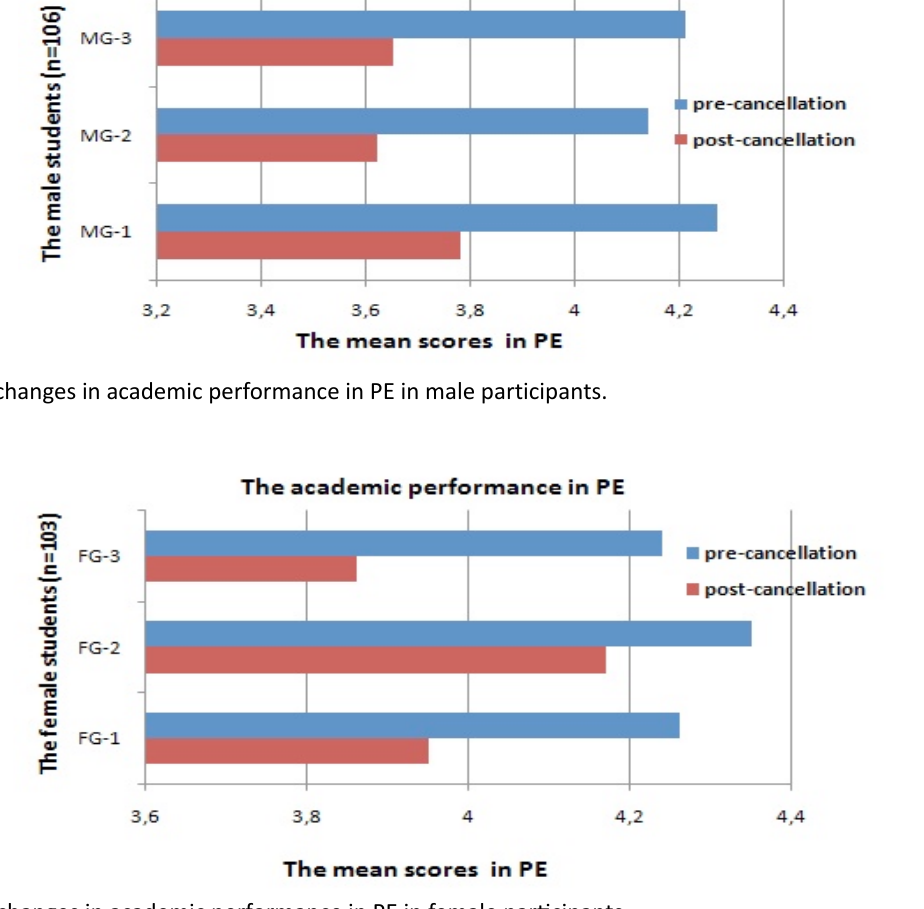
Fig. 2. The changes in academic performance in PE in female participants.